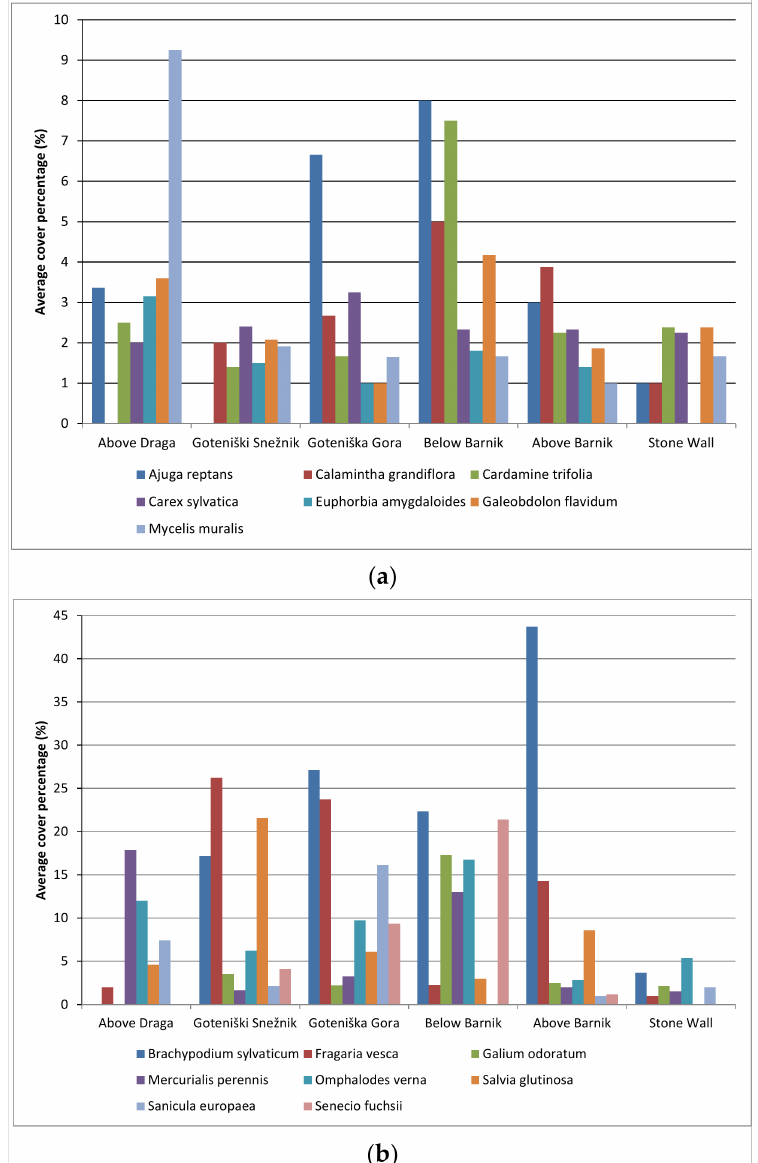
Figure 3. ( a ) Cover percentage change diagram between single sampling sites for first set of 15 chosen plant species (Above Draga/L6-2014, Goteniški Snežnik/L4-2013, Goteniška gora/L5-2011, Below Barnik/L2-2007, Above Barnik/L3-2007, control Stone Wall/L1-2000). ( b ) Cover percentage change diagram between single sampling sites for second set of 15 chosen plant species (Above Draga/L6-2014, Goteniški Snežnik/L4-2013, Goteniška gora/L5-2011, Below Barnik/L2-2007, Above Barnik/L3-2007, control Stone Wall/L1-